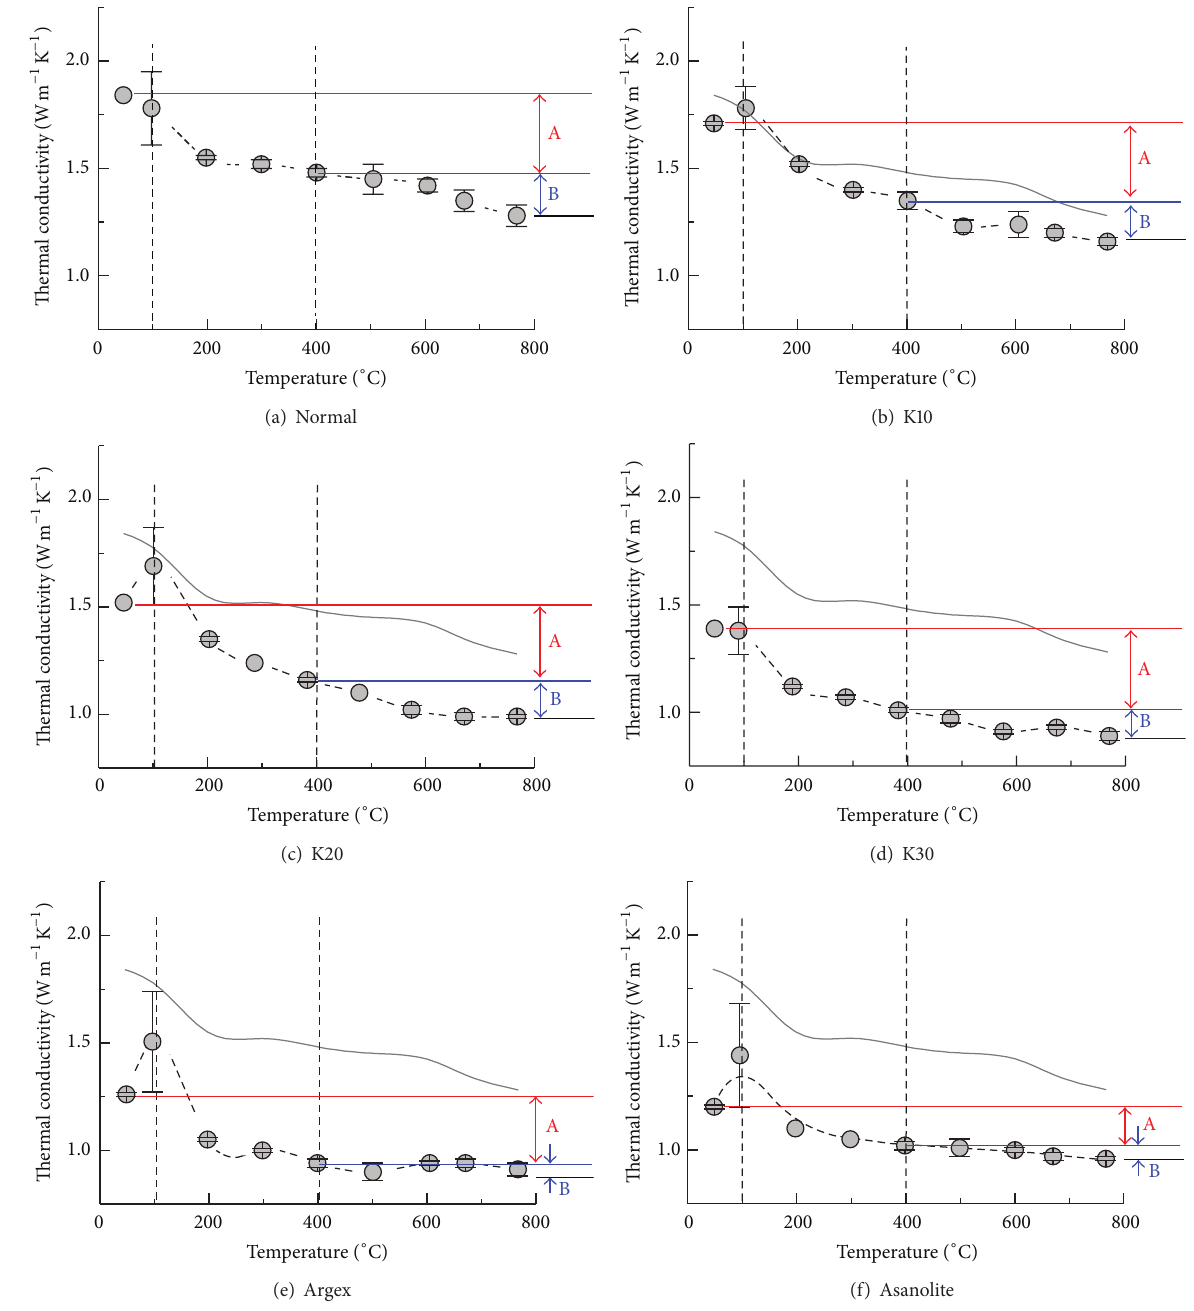
Figure 7: Temperature-dependent thermal conductivity of tested